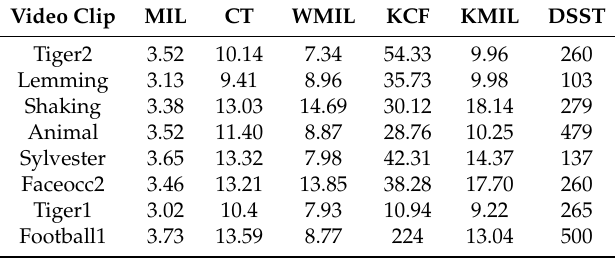
Table 2. The FPS (Frames Per Second) for different algorithms conducted on sequences “Tiger2”, “Lemming”, “Shaking”, “Deer”, “Sylvester”, “Faceocc1”, “Tiger1”,